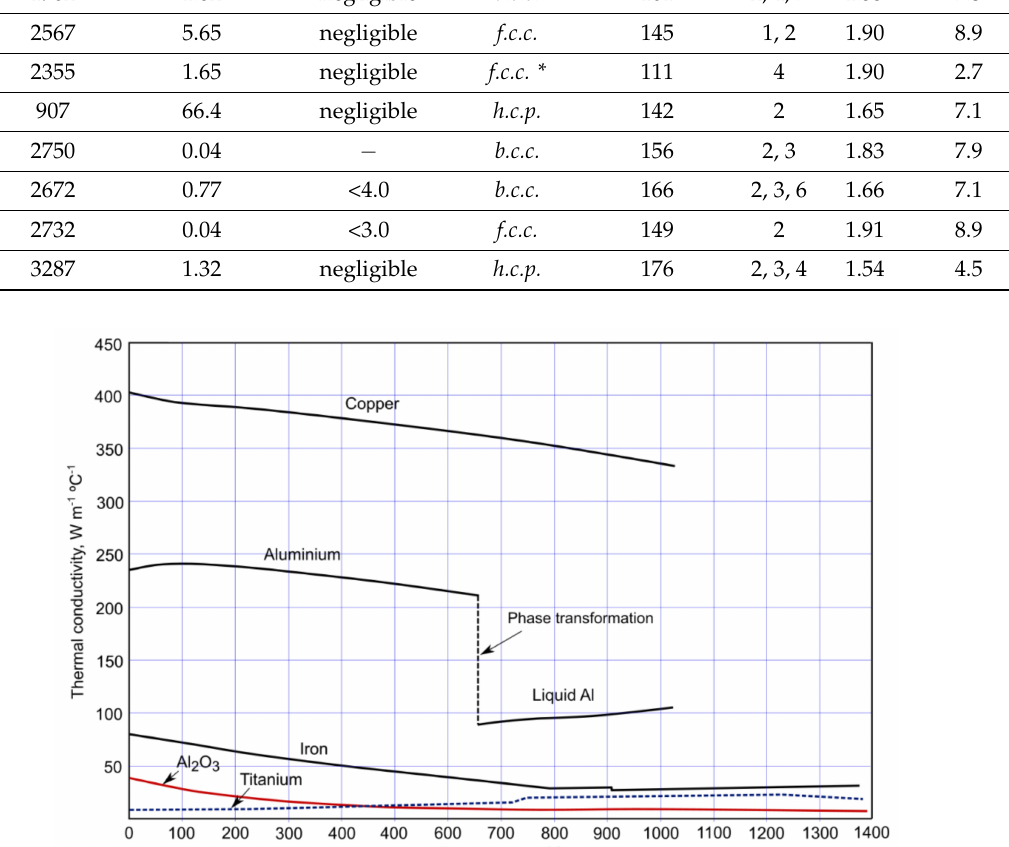
Figure 5. Thermal conductivity changes with temperature of different metals. Redrawn from